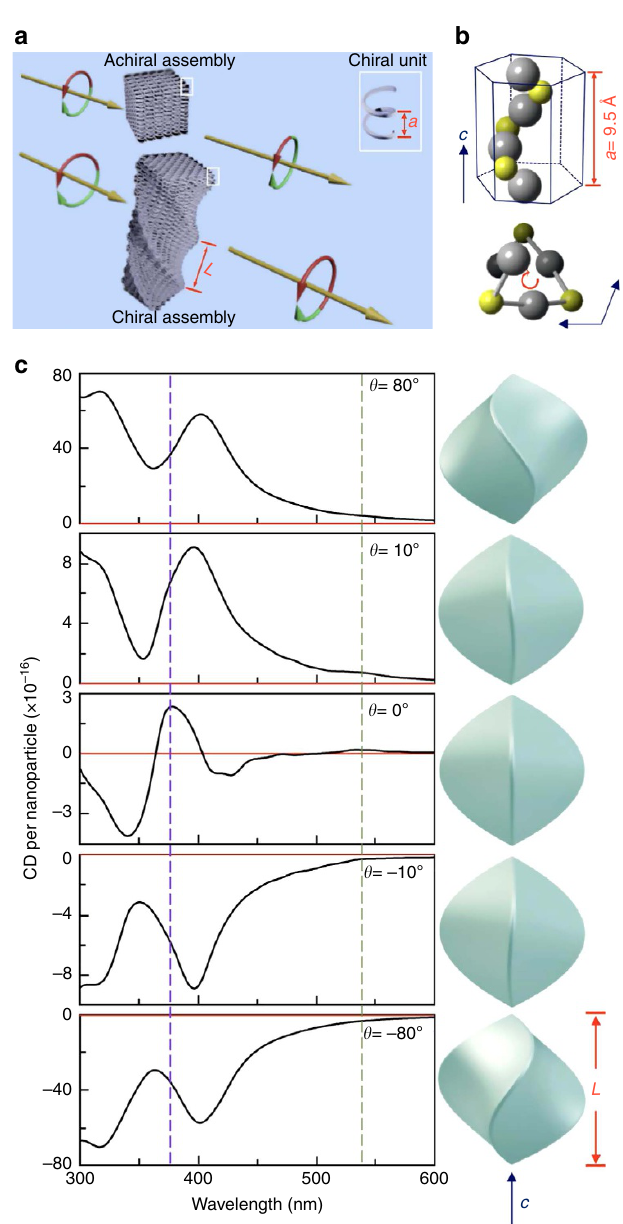
Figure 1 | Cooperative chirality at different length scales. ( a ) Schematic model of nanoscale assembly of chiral units with characteristic length a (highlighted by white rectangle). Such assemblies can possess either achiral or chiral morphology with characteristic length L , leading to different chiroptical response. ( b ) Atomic model of cinnabar HgS lattice along crystallographic c axis, showing helical arrangement of atoms. The top image shows the side view, and the bottom image shows the top view. Grey sphere, Hg atom. Yellow sphere, S atom. ( c ) Computed CD spectra of a twisted triangular bipyramid a -HgS with different twisting angle, while the crystallographic chirality remains unchanged. Corresponding structural model of simulated nanostructures is presented next to its CD spectroscopy. The simulation is performed with an incident wave vector that is 30 (cid:2) relative to the c axis of nanoparticle. Green and purple dashed lines are guides to the eyes for features near 540nm and 380nm, respectively. For all simulations, the L and aspect ratio of a -HgS nanostructures are set to be 150nm and 1,